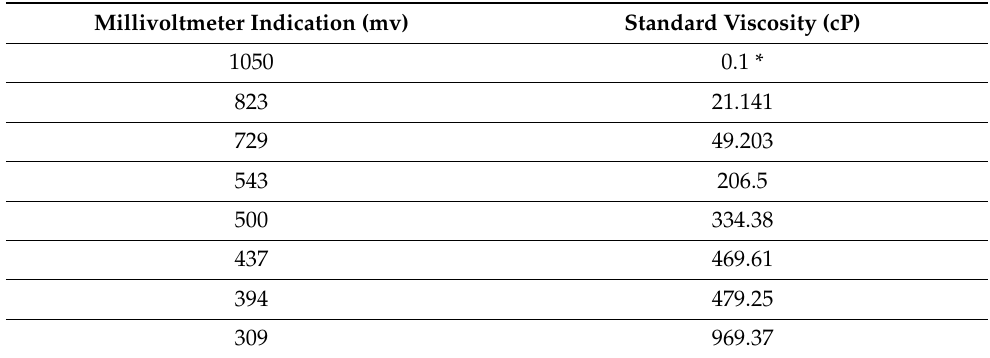
Figure 6. Temperature sensors used. ( a ) J-type sensor (Fe–Ct). ( b ) S-type sensor (Pt-Rh). ( c ) Sensor type PT100 sheath 150 mm-50/+400C 0628-0033-0.5. ( d ) Sensor type PT100B-6X150-A304-0000-3.0TTS. ( e ) Sensor type PT100B-6X100-MGO-0000-DIN/B. Table 3. Viscosity values measured and given by the standard. Millivoltmeter Indication (mv) Standard Viscosity (cP)